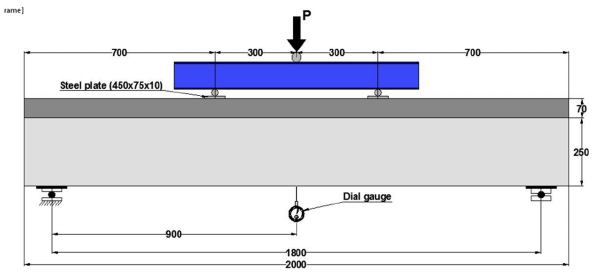
Figure 4: Schematic test setup